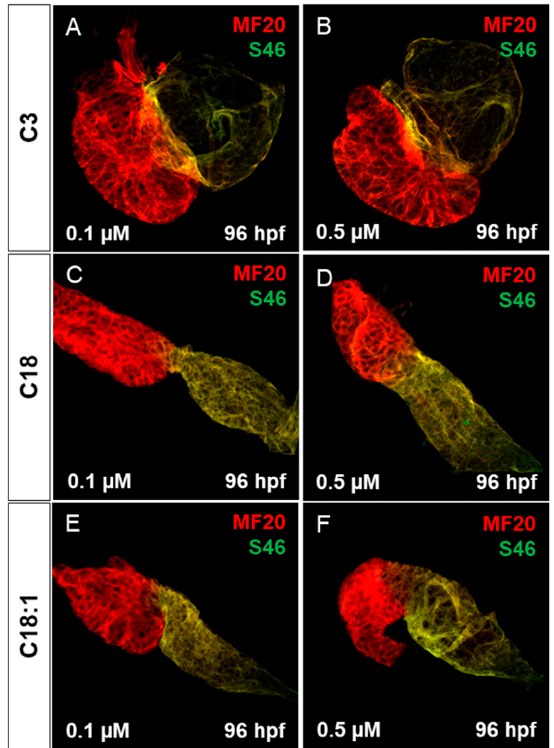
Figure 5. Cardiac chamber specification and development of LCAC-exposed zebrafish larvae. ( A – F ) Immunofluorescence staining of carnitine-treated embryonic hearts against sarcomeric myosin heavy chain (MF20) and slow developmental myosin heavy chain (S46).